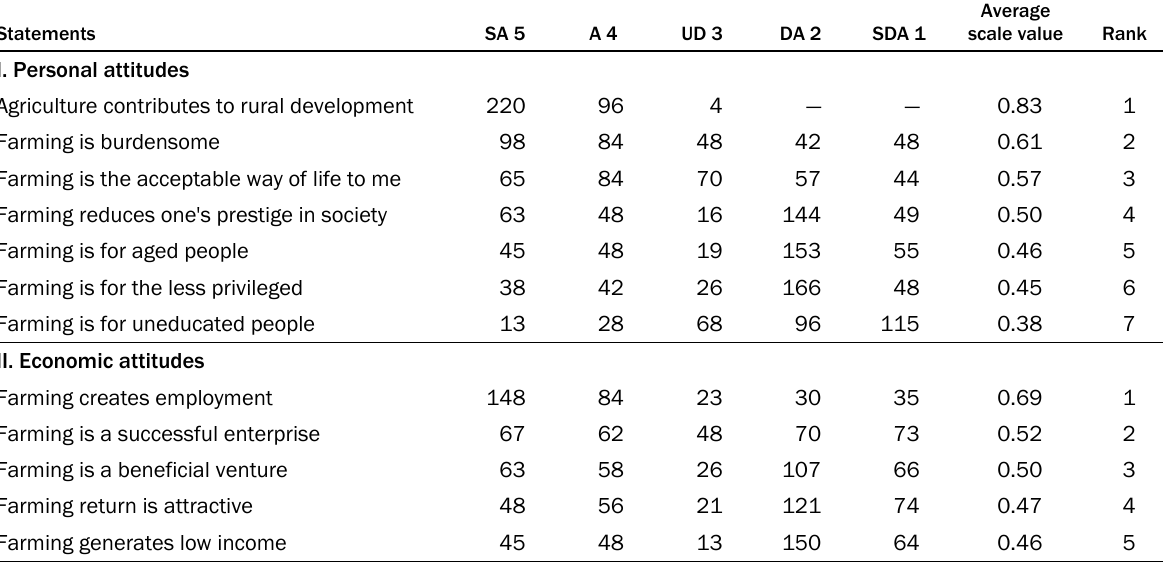
Table 5. Attitude of Youth Toward Agriculture ( N =320)